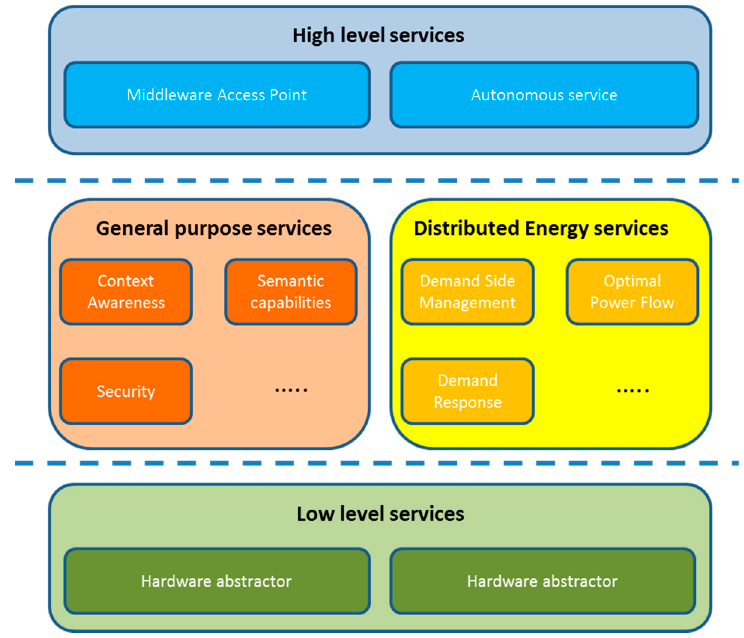
Figure 3. Middleware architecture for the smart grid.